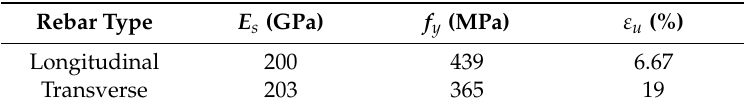
Table 8. Steel properties for set 2 specimens.